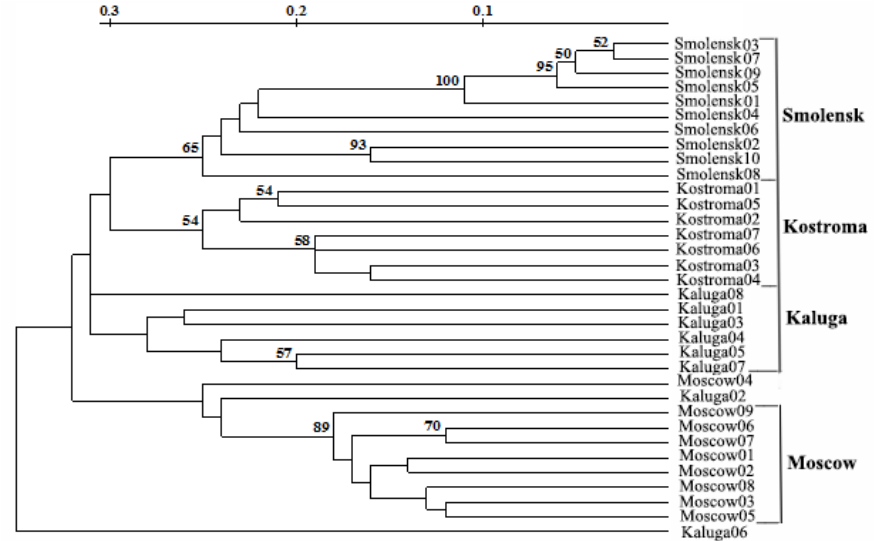
Figure 3. Phylogenetic tree of the invasive population of L. polyphyllus derived from the combination of RAPD, ISSR and REMAP data. The bootstrap values are given in %.